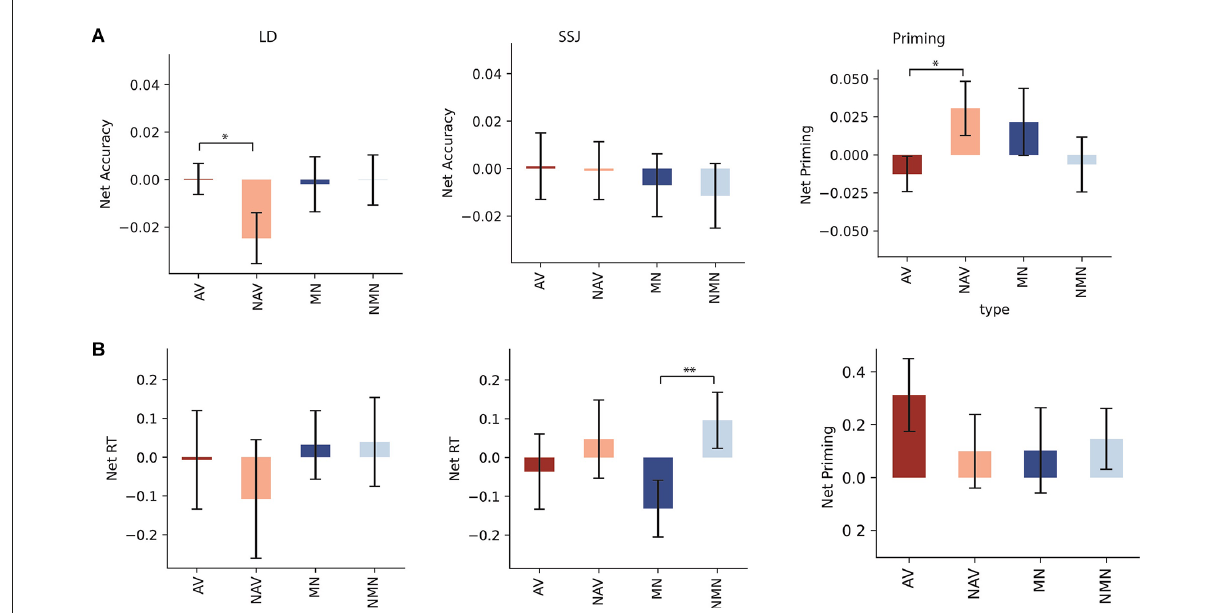
FIGURE3 (A) Net accuracy and (B) net RT following HMA stimulation for LD, SSJ, and priming. Net accuracy refers to the difference between accuracy following active and sham stimulations. Net RT refers to the difference in z score of response time between active and sham stimulation. Significant differences were marked with asterisk signs ( ∗∗ for p < 0.01 and ∗ for p < 0.05). Task abbreviations: AV, action verb; NAV, non-action verbs; MN, Manipulable nouns; NMN, Nonmanipulable nouns.